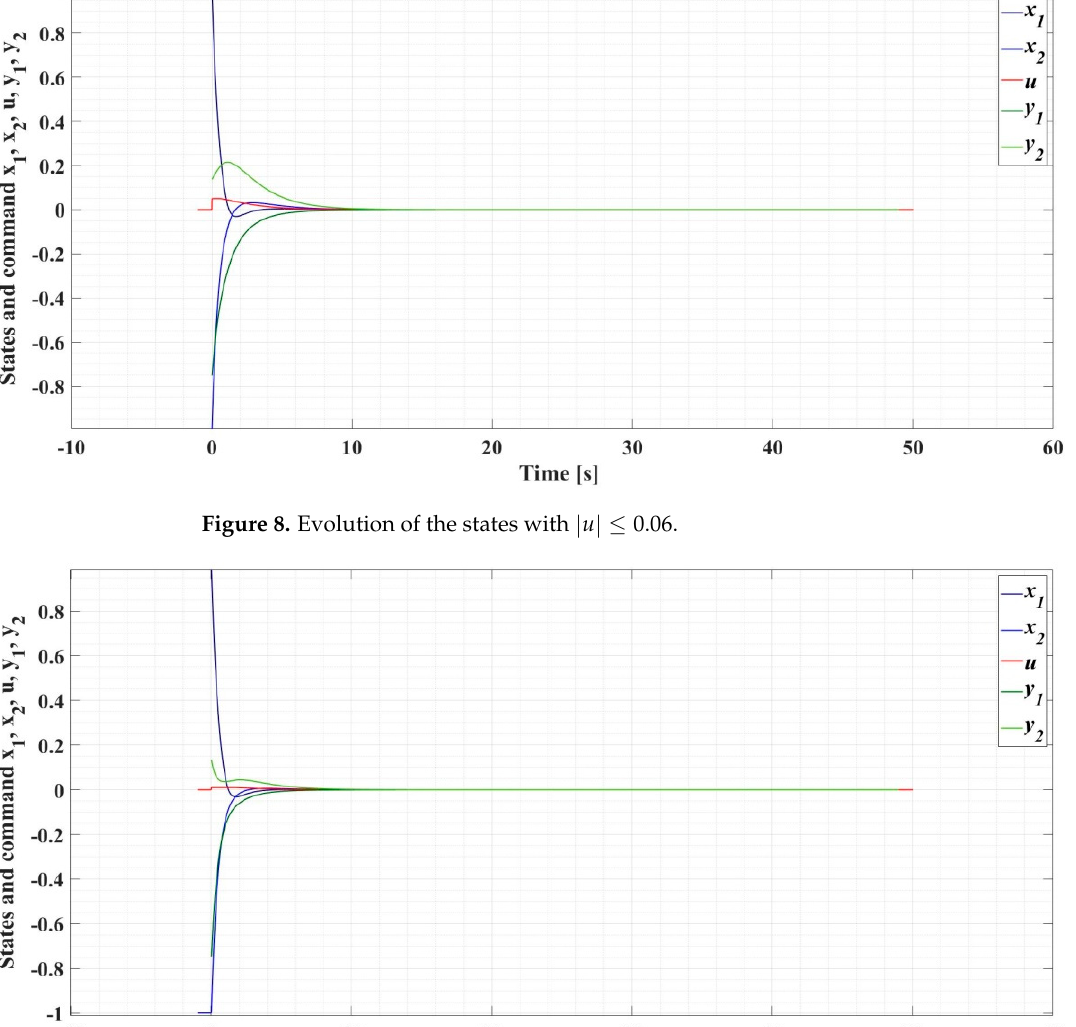
Figure 7. Evolution of the states without input saturation.